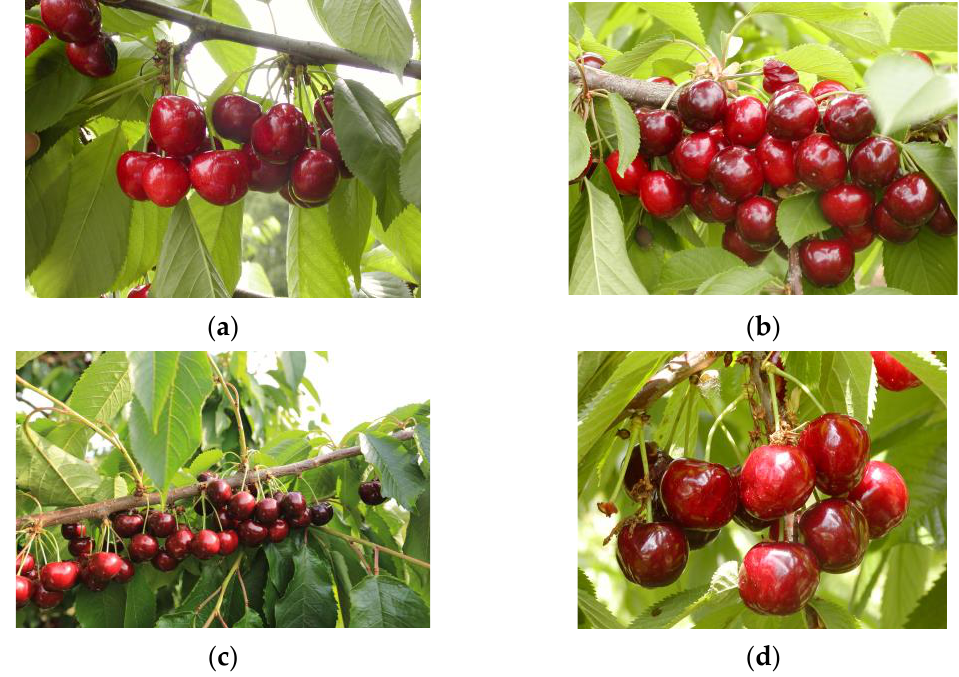
Figure 1. The investigated varieties: ( a ) ‘Carmen’; ( b ) ‘Vera’; ( c ) ‘Paulus’; ( d ) ‘Rita’. Site conditions. The trial was planted on a private farm in Ravazd, on high-quality soil, on loess developed slightly argillic brown earth, with close neutral pH (KCl) = 7.15, total lime content in the top 60 cm layer 4.3%, and humus content 2.41%. The latitude of the orchard location (47°5 2′29.55” N 17°74′39.12” E ) is 225 m on a slight slope in a south–southeast direction. This district of the settlement of Ravazd is classified as vineyard, which indicates the earlier and partly actual land use. The test orchard is part of a private farm maintained by the usual technology in plant protection and fertilizer application. The grass was mown in the alleyways. The spacing was 1.6 m in the row and 5 m between the rows, and tree height was restricted at 4.5 m by heading. From 2016 onward, summer pruning was applied (Figure